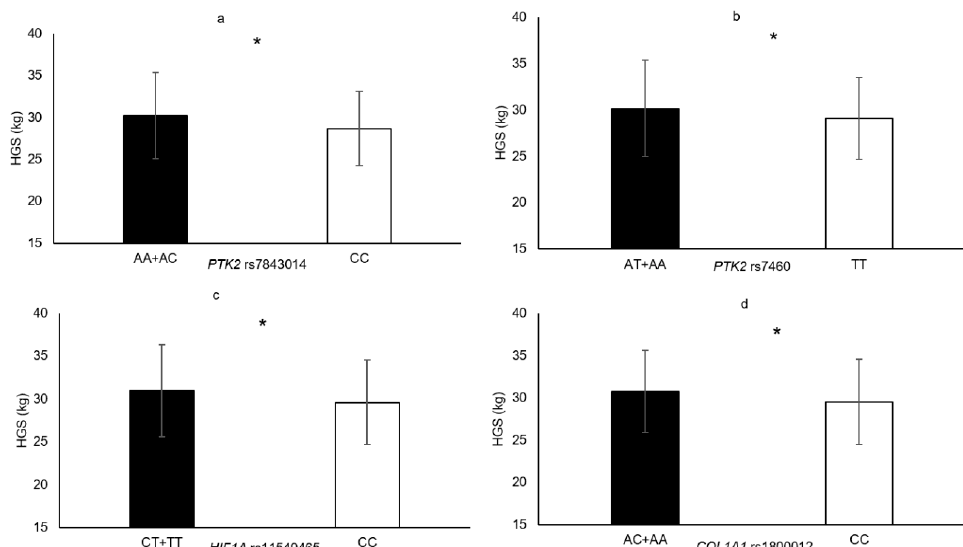
Figure 1. Handgrip strength in genotype groups for ( a ) PTK2 rs7843014 (AA + AC = 247 vs. CC = 57, Δ = 5.3%); ( b ) PTK2 rs7460 (TT = 72 vs. AT + AA = 233, Δ = 3.6%); ( c ) HIF1A rs11549465 (CT + TT = 64 vs. CC = 241, Δ = 4.6%); ( d ) COL1A1 rs1800012 (AA + AC = 99 vs. CC = 205, Δ = 4.1%). * denotes significant difference. Data are mean ± SD.